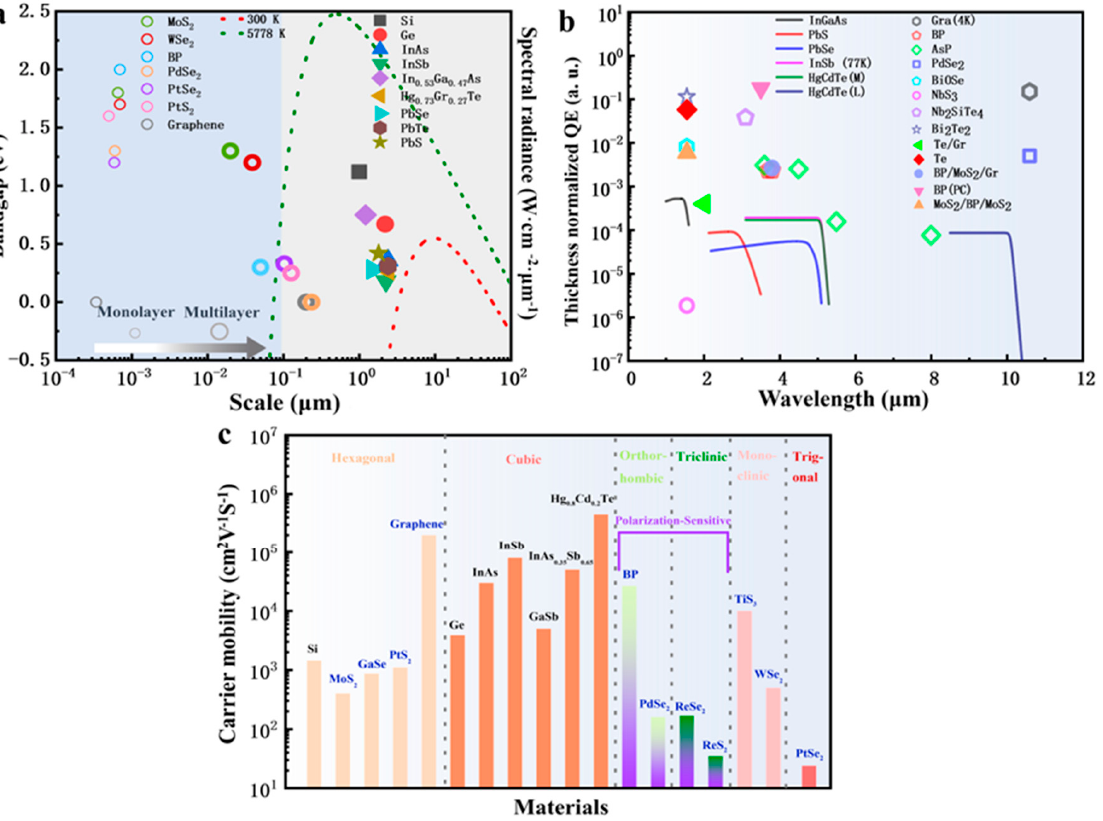
Figure 1. Physical properties comparison of 2D materials and 3D materials. ( a ) Bandgap comparison of 2D materials and 3D materials and spectral radiance for di ff erent temperature sources [17,54–60]. ( b ) Thickness-normalized EQE for di ff erent materials: the sca tt er represents the 2D-layered materi- als, while the line represents traditional thin fi lm materials [17,45,61–71]. (Hollow symbol represents measured results of laser source, and solid symbol and solid lines represent the result of blackbody source.) ( c ) Comparison of carrier mobility in di ff erent crystal system. Graphene and HgCdTe ex- hibit ultra-high carrier mobility, orthorhombic BP, PdSe 2 and triclinic ReSe 2 , ReS 2 exhibit polariza- tion-sensitive properties [57,72–80]. Figure 2. High-quality van der Waals heterojunction interface and modulation of 2D materials P, N conduction type. Schematic diagrams and TEM images of ( a ) BP/MoS 2 /graphene photodetector [45] (copyright 2021, Springer Nature). ( b ) InSe/BP heterojunction [46] (copyright 2019, Springer